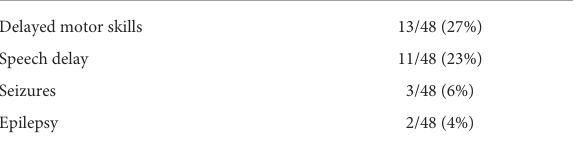
TABLE 4 Long-term neurological